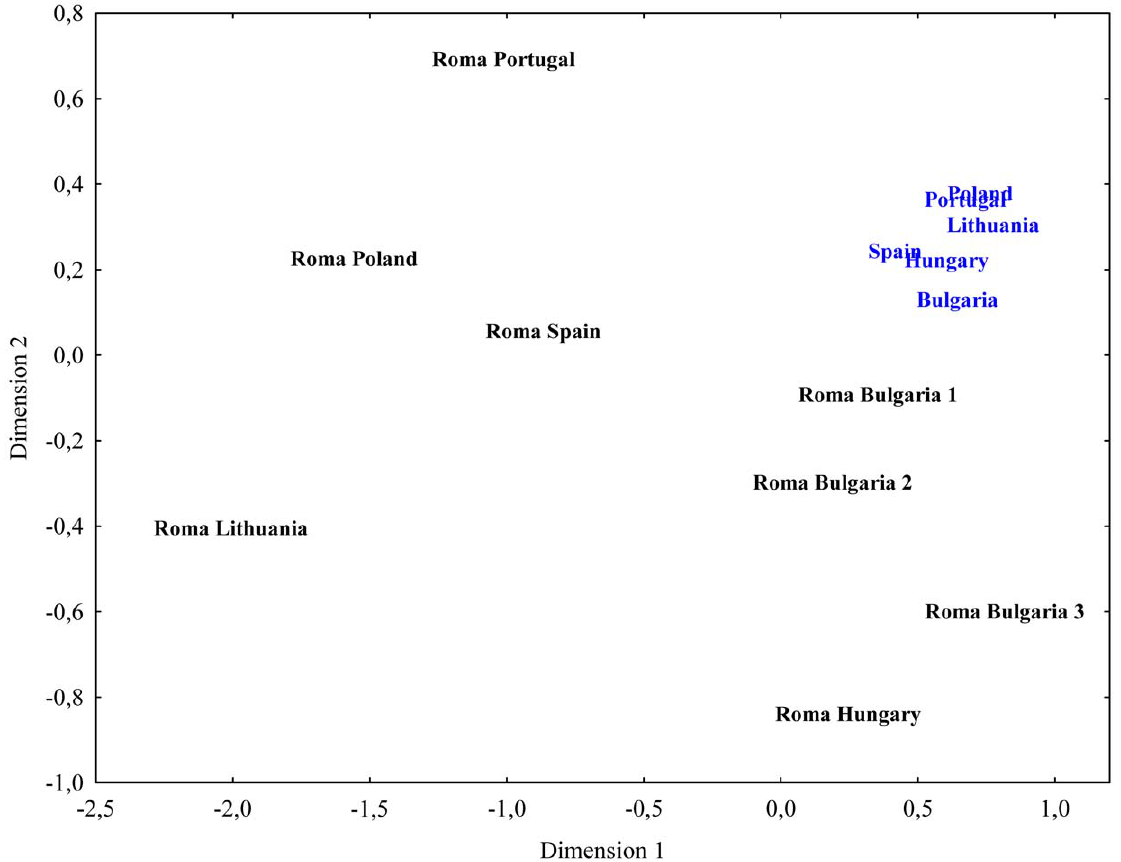
Figure 2. Non-metric Multidimensional Scaling plot (NMDS) of the pairwise differences between Roma and the corresponding host populations (stress value=0.068). The labels ‘‘Roma Bulgaria 1’’, ‘‘Roma Bulgaria 2’’ and ‘‘Roma Bulgaria 3’’ stand for Bulgarian Roma populations grouped according to history of migrations as in Gresham et al. [6].